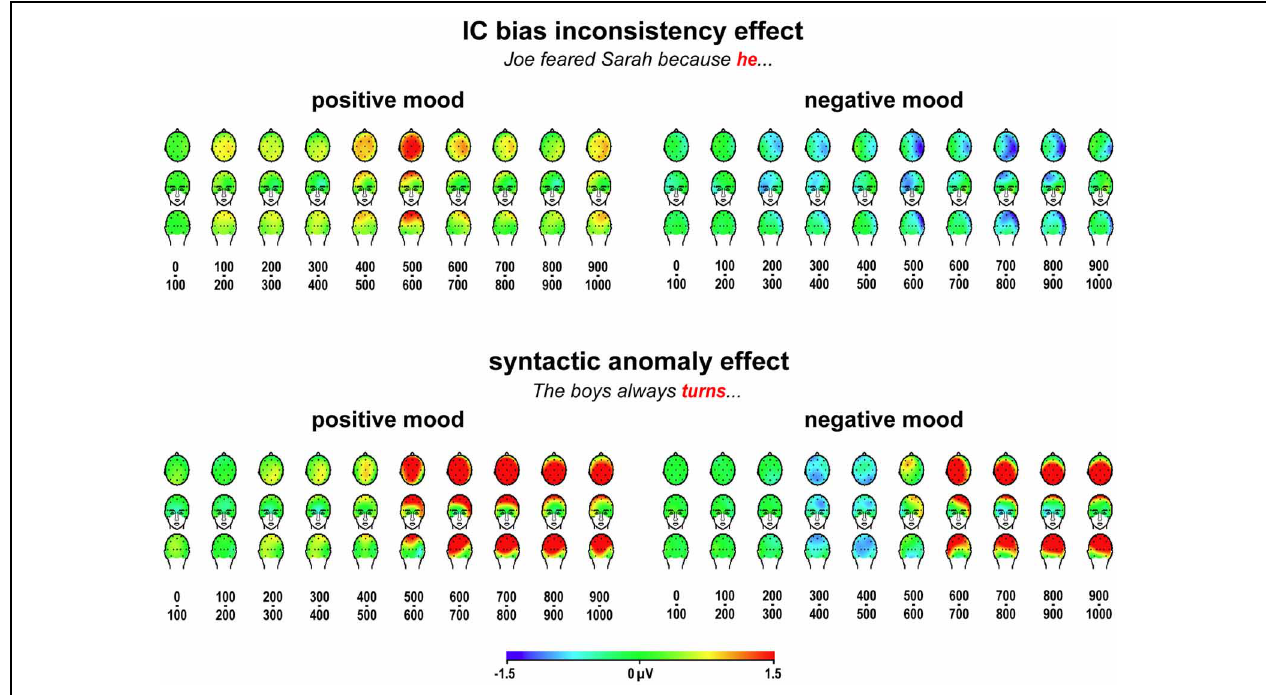
FIGURE 3 | ERP effects to implicit causality bias inconsistency and syntactic anomaly. Scalp distributions of grand average differential ERP effects to bias-inconsistent (vs. -consistent) pronouns, and to